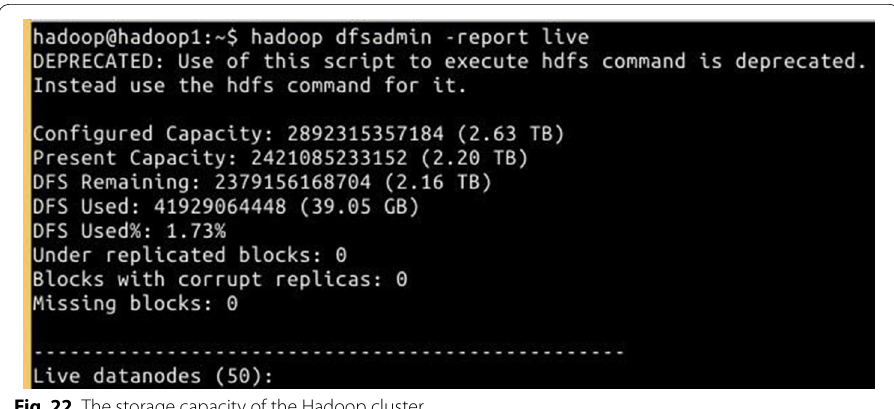
Fig. 22 The storage capacity of the Hadoop